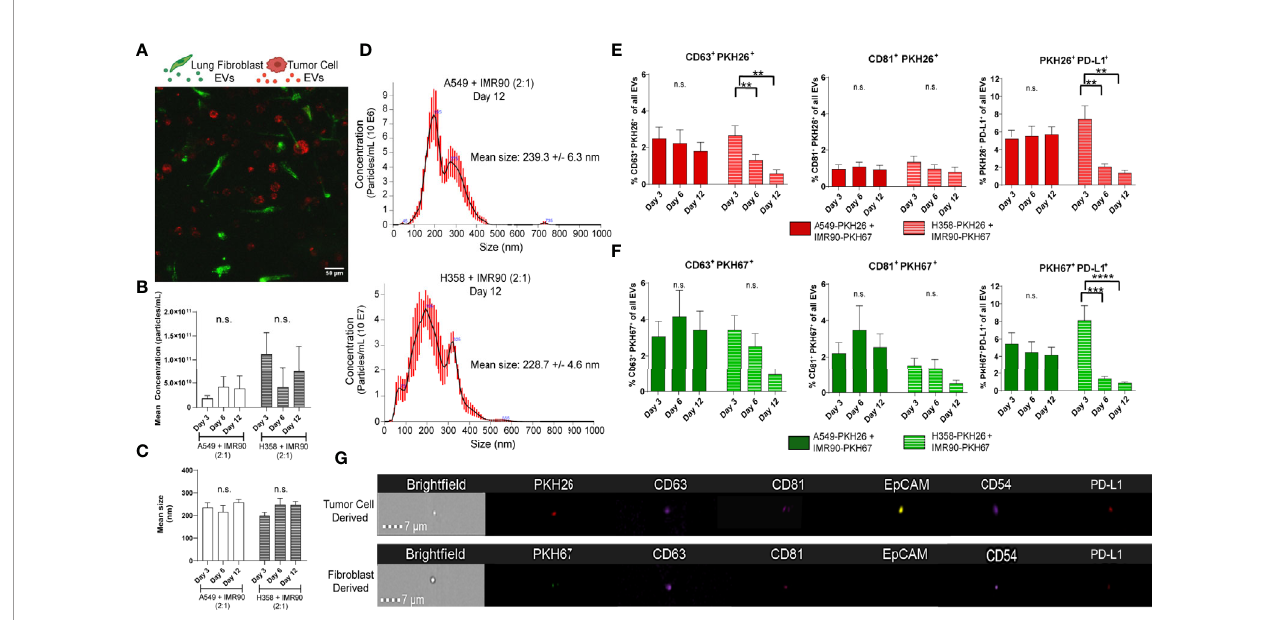
FIGURE 4 | Extracellular Vesicles within Circulating Media have Immunomodulatory Potential. (A) Confocal image from day 3 of culture, showing PKH26 labeled tumor cells (red) and PKH67 labeled fi broblasts (green) in co-culture within the bioreactor. (B, C) No changes in mean concentration (B) or size (C) were found in either tumor model with EV particle analysis. (D) Representative particle analyses for each tumor model. (E) Tumor cell-derived EVs (PKH26 + ) express common exosome markers (CD63 and CD81) as well as PD-L1. (F) Fibroblast-derived EVs (PKH67 + ) express common exosome markers (CD63 and CD81) as well as PD-L1. (G) Representative imagestrips of tumor cell-derived and fi broblast-derived EVs showing PKH signal as well as expression of common EV markers and PD-L1. n=3-9 replicates per time point. ns, not signi fi cant, **p<0.01, *** p<0.001,